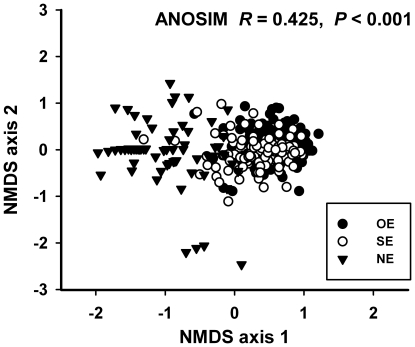
Arthropod community composition in detached Spondias
purpurea branches.OE  =  O. albomarginata
chamela-engineered branches; SE  = 
simulated-engineered branches; and NE  = 
non-engineered branches. Each point is a two-dimensional (axis 1 and
axis 2) representation of the arthropod community composition on an
individual branch based on global non-metric multidimensional scaling
(NMDS) analysis (stress  = 0.19).